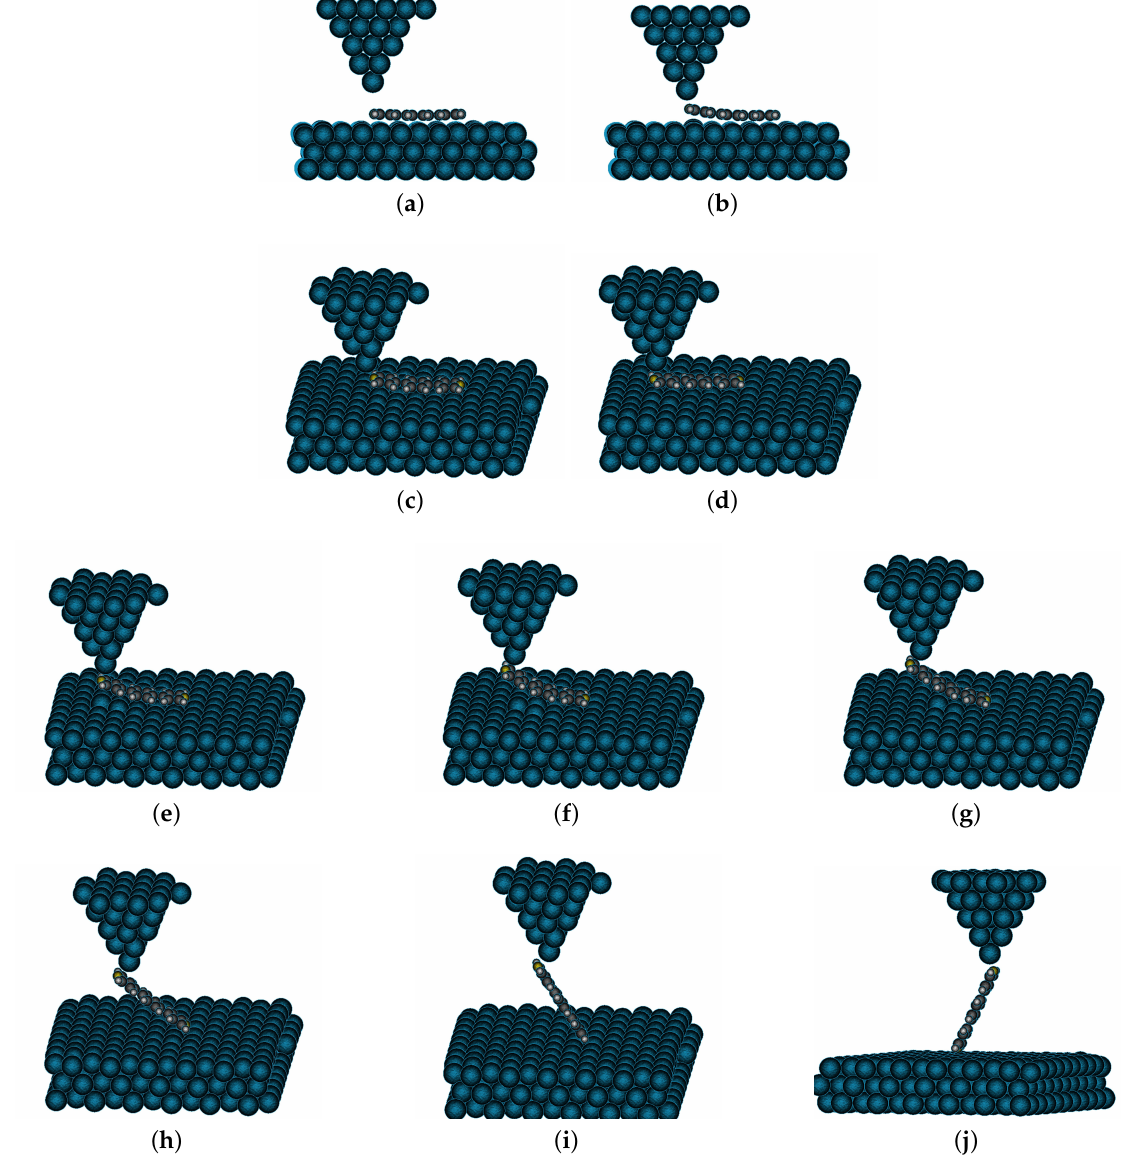
Figure 6. Snapshots for different manipulation operations performed using our GPU implementation of the real-time MD simulation. ( a ) The metallic tip is brought close to the N atom in the 1,4-bis(4-pyridyl)benzene molecule followed by a bond formation at ( b ). ( c , d ) The molecule is dragged over the Au(111) surface using the Au tip. After this sequence, ( e – j ) shows a lifting operation of the molecule from the metallic